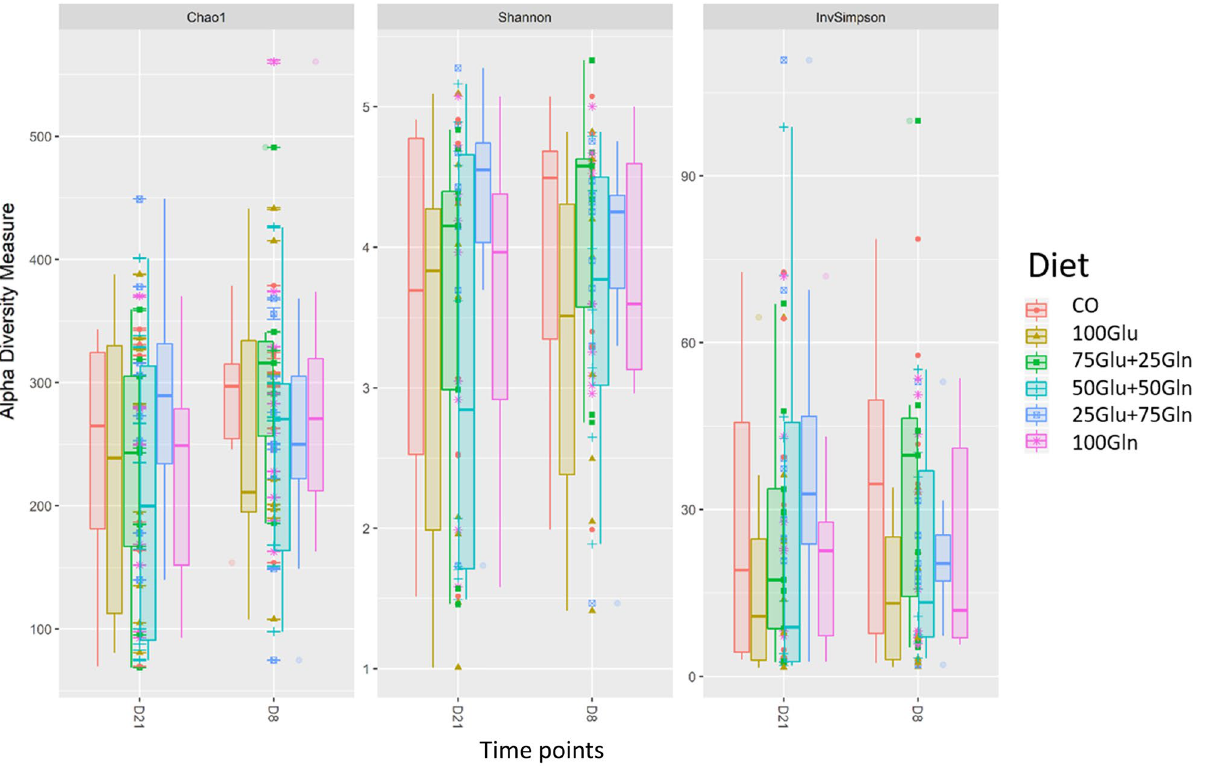
Figure 2. Alpha diversity indices per Diet and time points (day 21 and day 8 post-weaning). Diet: CO = standard diet; 100Glu = CO plus 6 kg/Ton Glu; 75Glu + 25Gln = CO plus 4.5 kg/Ton Glu and 1.5 kg/Ton Gln; 50Glu + 50Gln = CO plus 3 kg/Ton Glu plus 3 kg/Ton Gln; 25Glu + 75Gln = CO plus 1.5 kg/Ton Glu and 4.5 kg/Ton Gln; 100Gln = CO plus 6 kg/Ton in Supplementary Fig. 1. Considering the overall samples, eighteen different phyla were identified in the caecum; the most abundant phylum was Firmicutes (70%) followed by Bacteroidetes (17%). At the family level, eighty different genera were assigned; the most abundant were Peptostreptococcaceae (18%), and Eryspelotrichaceae (17%). At the genus level, the most abundant assigned genera were Turicibacter (15%) and Terrisporobacter (13%). Figure 2 shows the Alpha diversity indices of the dietary groups at the two time points. The dietary groups showed a fairly constant ASVs distribution in the caecum; the Alpha index values (Chao1, Shannon and InvSimpson) were not affected by diet. Time did not influence the Shannon and InvSimpson indices, but reduced the Chao1 index from d8 (265) to d21 (231) ( P = 0.008). For the Beta diversity index (Bray–Curtis distance), a clear effect of time was observed ( P = 0.01; R 2 = 0.068). Two well-defined clusters regarding time were shown in the Non-Metric Multidimensional Scaling (NMDS) plot of the Bray–Curtis distance matrix (Supplementary Fig. 2). Diet did not affect the Beta diversity index. Results for the different taxa of the dietary groups at the fam- ily and genera levels at d8 and d21 are reported in Table 3. At d8, the 100Gln group had a lower abundance of family Fusobacteriaceae as compared with the CO group (adj.p < 0.0001); considering the comparison between the Glu alone group vs . the mixed addition groups, the 100Glu group had a lower relative abundance of Entero- coccaceae (adj.p < 0.0001) and Lactobacillaceae (adj.p < 0.0001), and a higher abundance of Erysipelotrichaceae (adj.p = 0.02). Considering the comparison between the Gln alone group vs . the mixed addition groups, the 100Gln group had a lower abundance of Fusobacteriaceae (adj.p < 0.0001) and a higher level of Clostridi- ales_vadinBB60_group (adj.p = 0.001). Considering the comparisons at the genus level at d8, the CO group had a higher relative abundance of Selenomonas (adj.p = 0.007) and Mogibacterium (adj.p < 0.0001) than the 100Glu group, a higher relative abundance of Pelistega (adj.p < 0.0001) and Selenomonas (adj.p = 0.006) than the 50Glu + 50Gln group, a higher relative abundance of Selenomonas (adj.p = 0.004) and Blautia (adj.p = 0.023) than the 25Glu + 75Gln group and a higher relative abundance of Fusobacterium (adj.p < 0.0001) and UB1819 (Family Ruminococcaceae) (adj.p < 0.0001) as compared with the 100Gln group. The comparison between the Glu alone group or the Gln alone group vs. the AAs mixed diets showed a decrease in the relative abundance of Pediococ- cus (adj.p < 0.0001), Enterococcus (adj.p < 0.0001) and Lactobacillus (adj.p = 0.008), in the 100Glu group, and a decrease in Pediococcus (adj.p < 0.05) and Fusobacterium (adj.p < 0.0001) in the 100Gln group. At d21, the CO group had a lower abundance of Fibrobacteraceae vs. each of the groups supplemented with AAs (adj.p < 0.0001) and a lower relative abundance of Bacteroidales_RF16_group (adj.p = 0.028) and Peptococcaceae as compared with the 100Gln group (adj.p = 0.037). Considering the comparisons at the genus level at d21, the CO group had a lower relative abundance of Selenomonas_3 as compared with the 100Glu group (adj.p = 0.006) and the